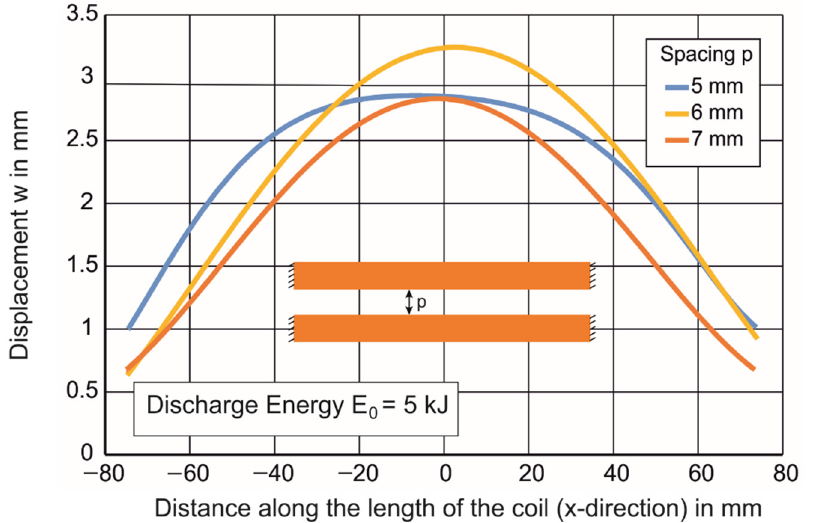
Figure 13. Experimentally measured deformation of the coil along the coil length towards one another in x-direction due to attractive Lorentz forces for three different coil spacings. The coordinate directions are shown in Figure 2.